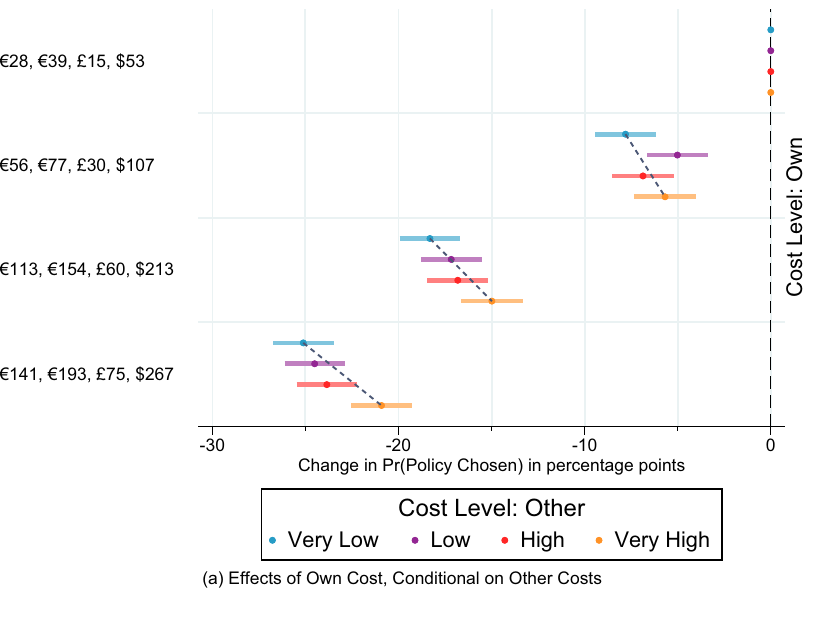
own cost if other costs very high and own costs if other costs very low. Error bars indicate95%con fi denceintervals.Resultsfortheunweighteddataareverysimilar, seeSupplementaryFig.8.ResultsbycountryareshowninSupplementaryFig.9. N (France)=32,000, N (Germany)=32,000, N (UnitedKingdom)=32,000, N (United